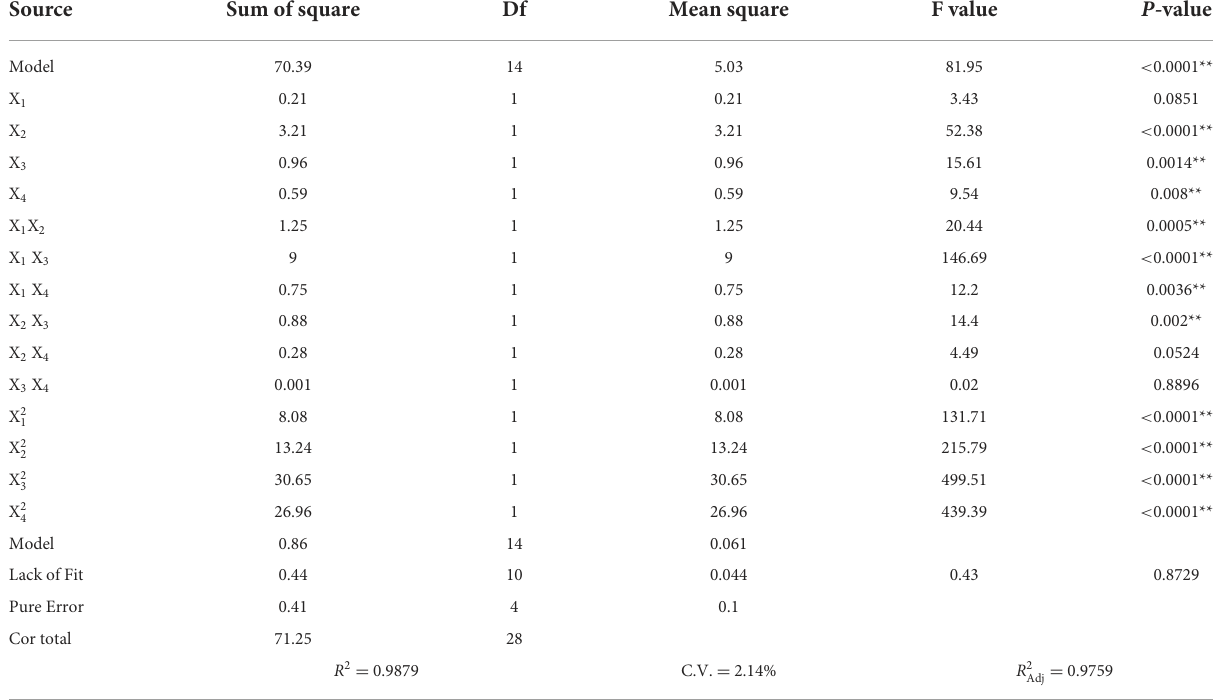
TABLE 3 Analysis of variance and results of regression equation. Source Sum of